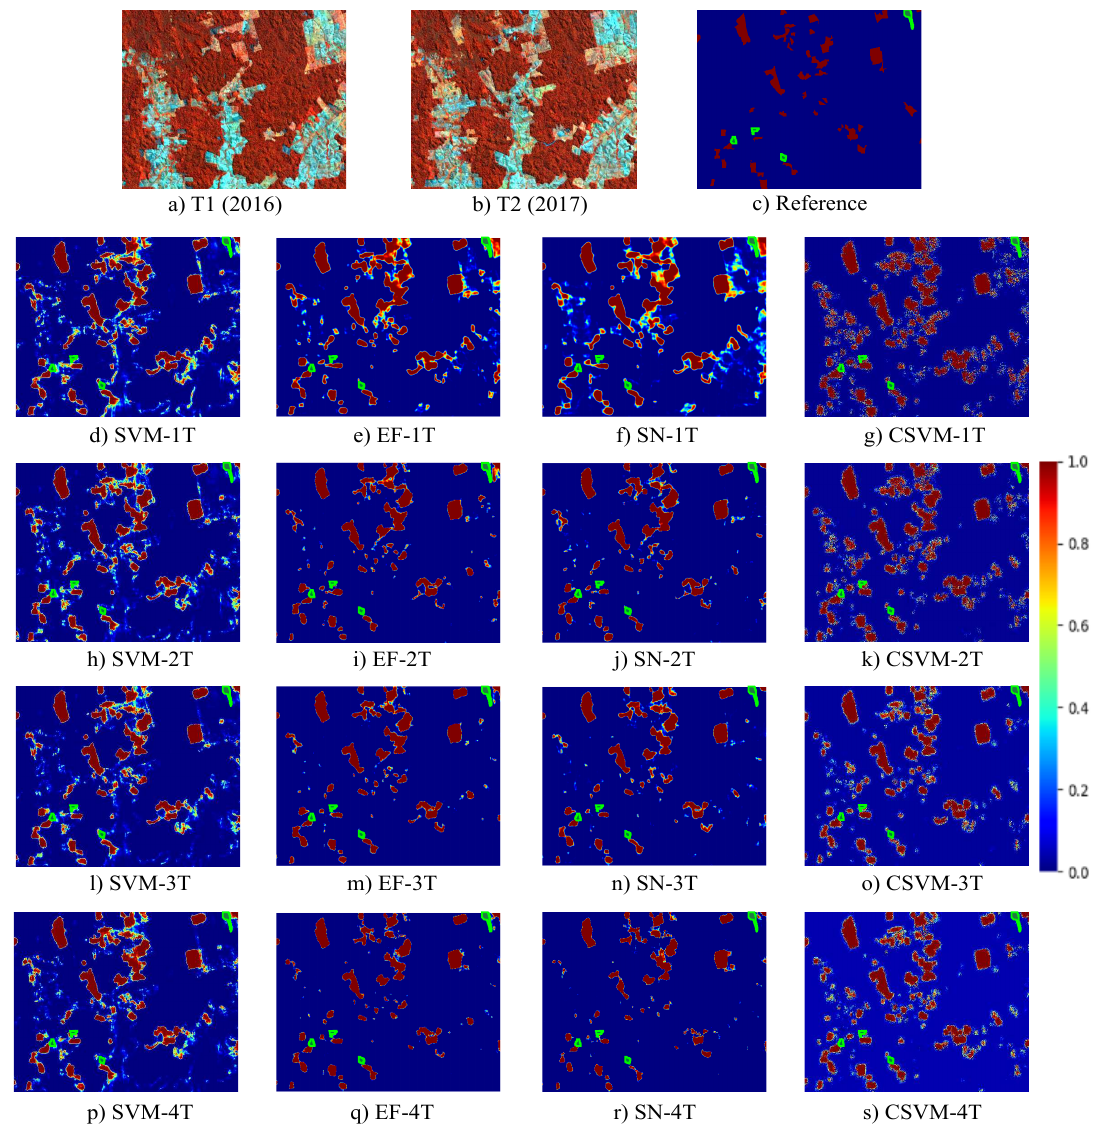
Figure 12. Predicted maps for tile 14 computed by SVM, EF, SN, and CSVM using one, two, three, and four tiles for